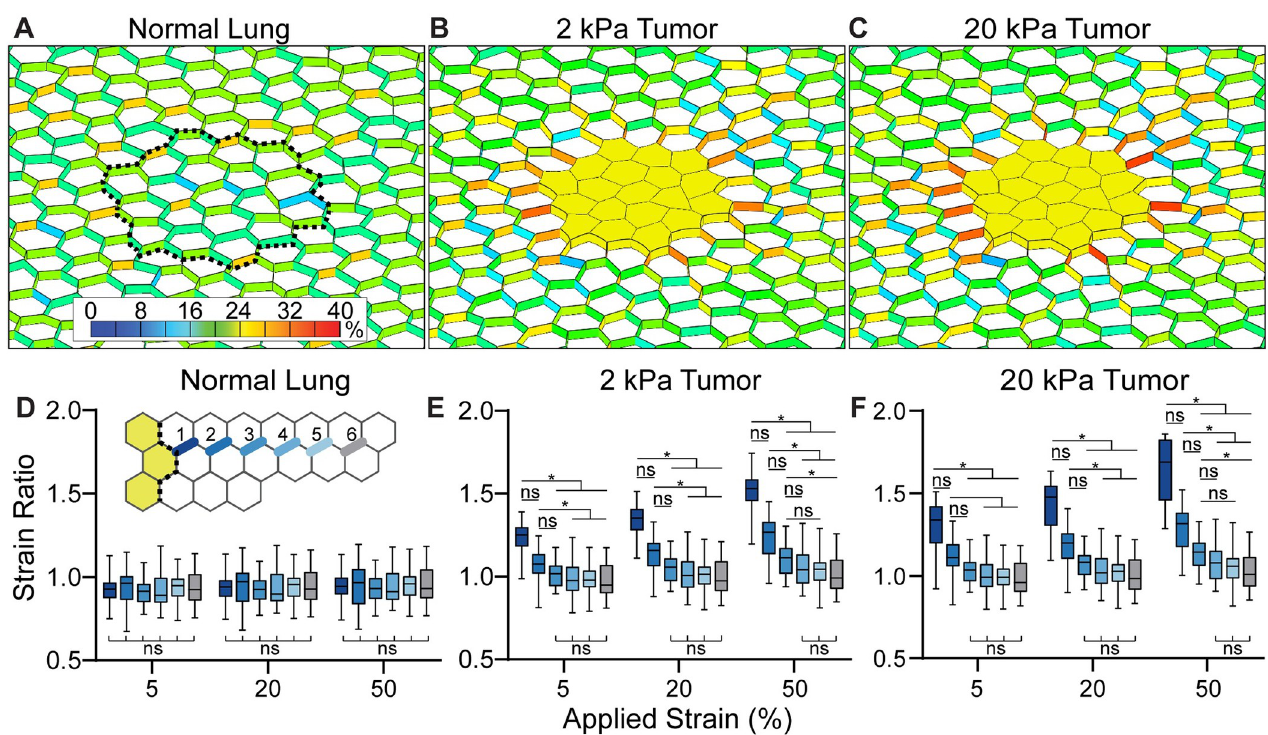
Fig 3. Lung tumors amplify strain in surrounding alveoli during inspiration. Strain colormaps after 20% stretch. A. Normal lung, B. lung with 2 kPa early tumor, and C. lung with a 20 kPa late tumor. Dotted line represents the location on the normal mesh of the tumor boundary. Colormap is % Green-Lagrange shell strain. D-F. Strain ratios in each model. Inset in D. is a schematic of the measured alveolar wall segments in which the dark-to-light colors represent the distance from the tumor edge. Boxes are 25 th percentile to 75 th percentile with the median and maximum and minimum values labeled. In D., for all comparisons of strain ratio in the normal lung, p > 0.999. Distribution includes all alveolar wall segments at each indicated distance.